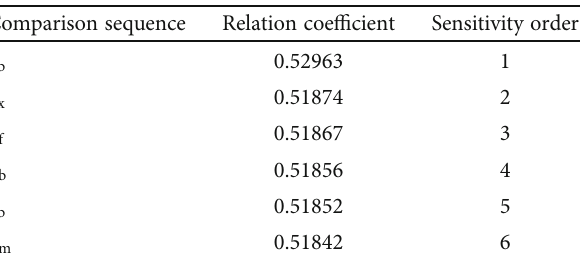
Table 3: Calculation